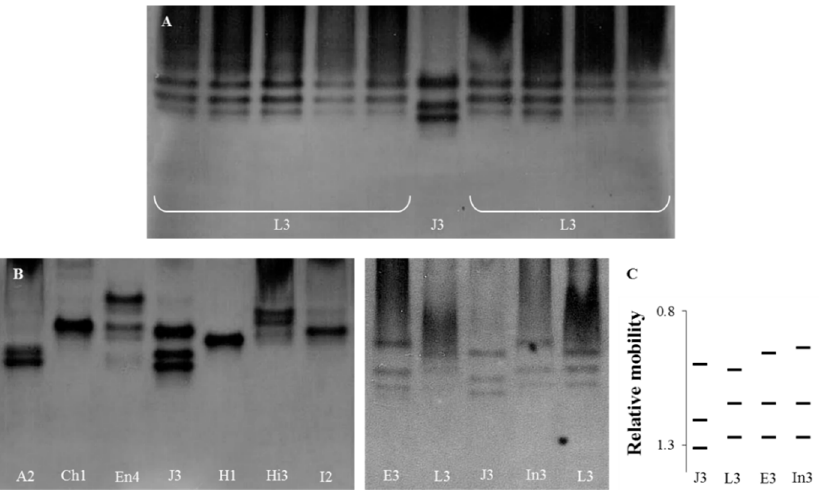
Figure 1. Esterase phenotypes of protein homogenates from five egg-laying females of Meloidogyne species isolates. From left to right: ( A ) L3— M. luci (isolates PtL1, PtL2, PtL3, BrL, GrL1), J3— M. javanica (reference isolate); L3— M. luci (isolates GrL2, ItL, SvL, TrL); ( B ) A2— M. arenaria ; Ch1— M. chitwoodi ; En4— M. enterolobii ; J3— M. javanica (reference isolate); H1— M. hapla ; Hi3— M. hispanica ; I2— M. incognita ; E3— M. ethiopica ; L3— M. luci (PtL1); J3— M. javanica (reference isolate), In3— M.